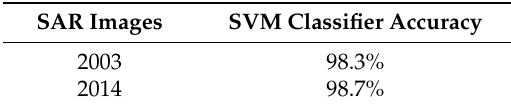
Table 6. Comparison of the overall accuracy result.